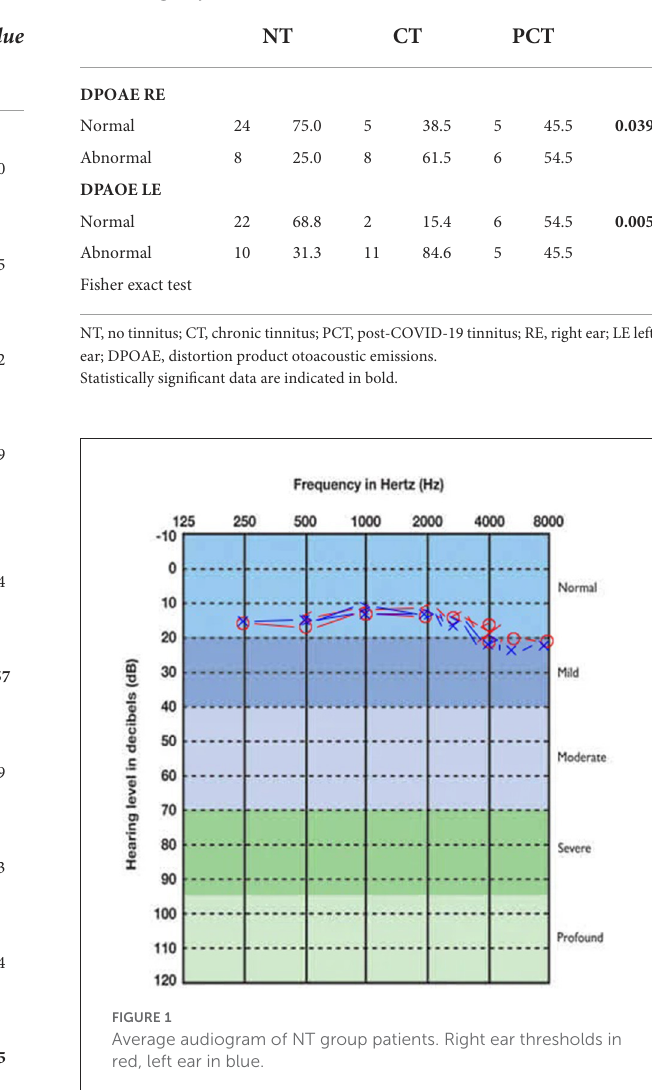
of COVID-19 infection on patients who already had